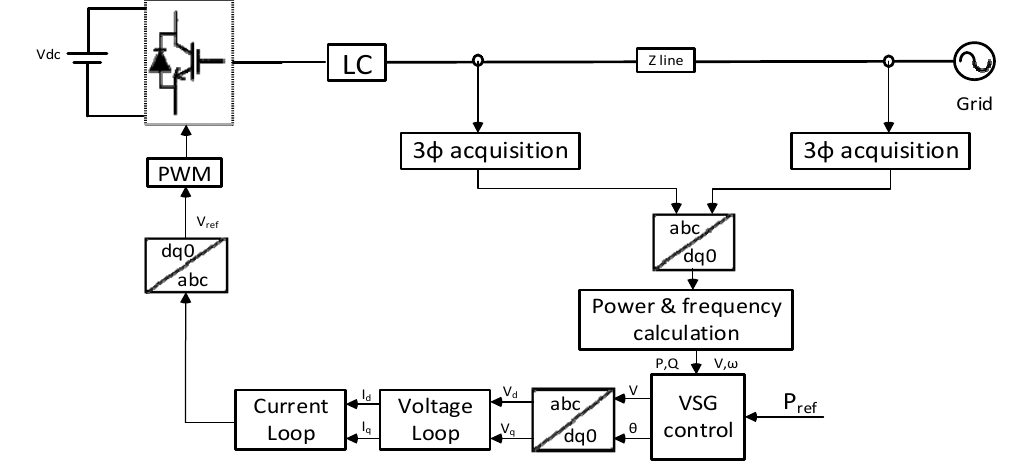
Figure 3. Overall control of VSG connected grid.